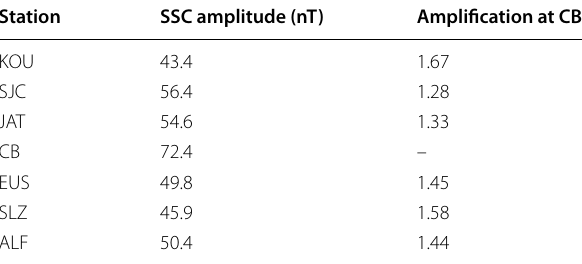
CB amplification is the ratio of the amplitude at the CB station to that at the other stations